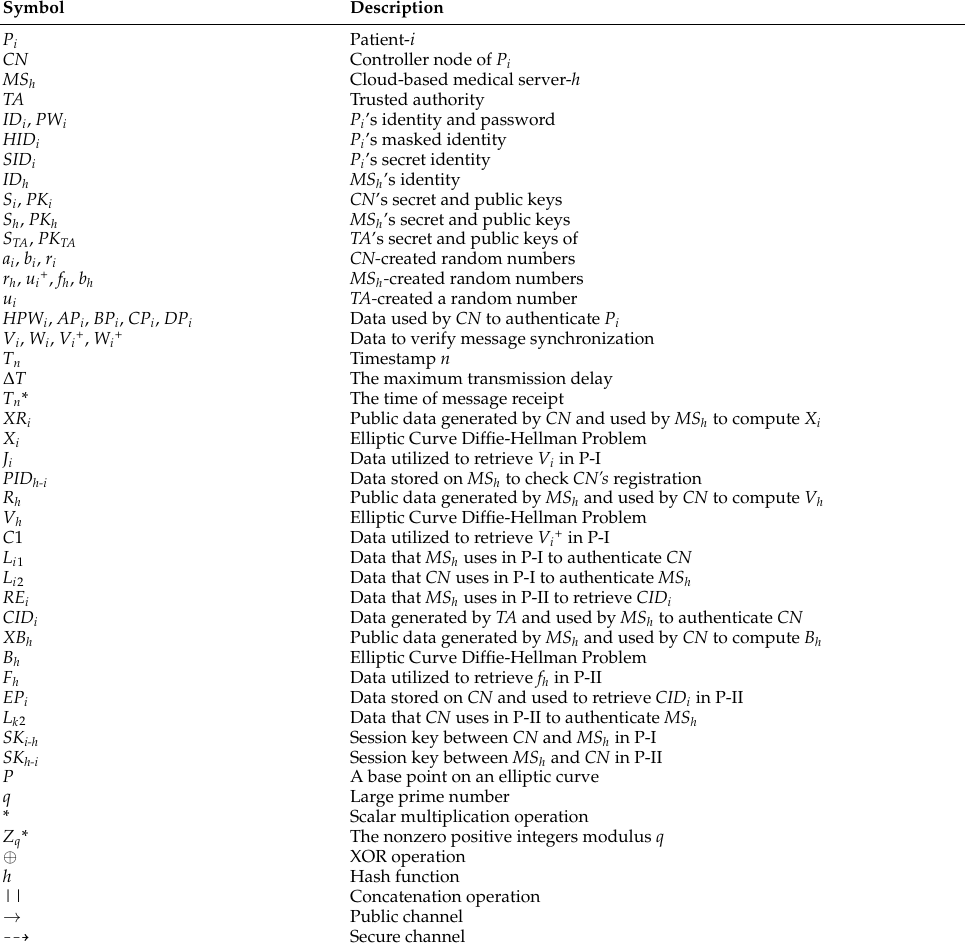
Table 1. Symbols utilized in our